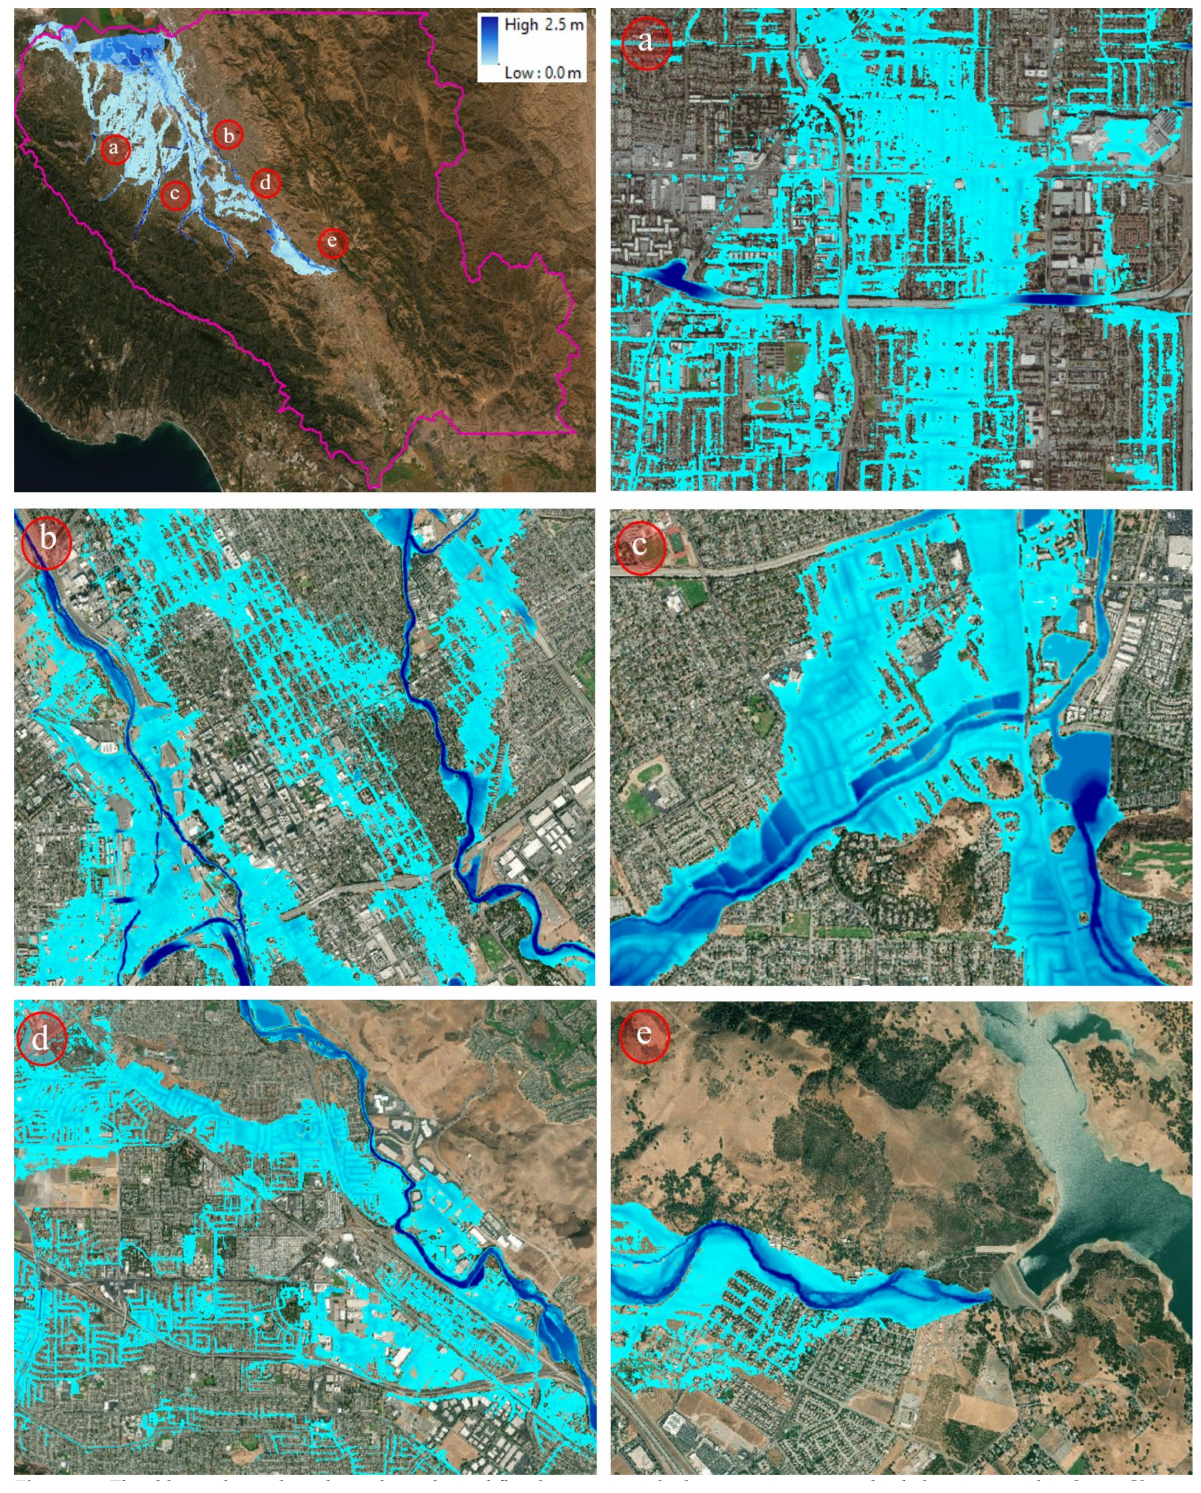
Figure 11. Flood hazard map based on a hypothetical flood scenario with close-up views on multiple locations within Santa Clara County as shown in ( a – e